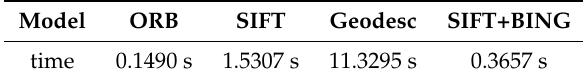
Table 10. The consumed time comparison of per matching pair of the fine stage with ORB, SIFT, Geodesc, and BING+SIFT, respectively, on the Chengyuan